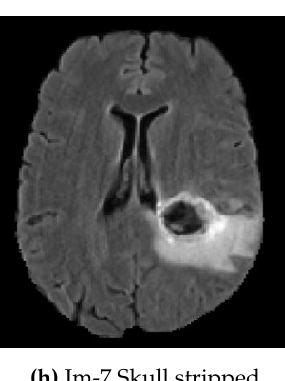
Figure 2. Examples of original abnormal brain tumor images before and after skull removed. ( a , c , e , g ) represent original brain images with skull; ( b , d , f , h ) represent the skull removed original brain